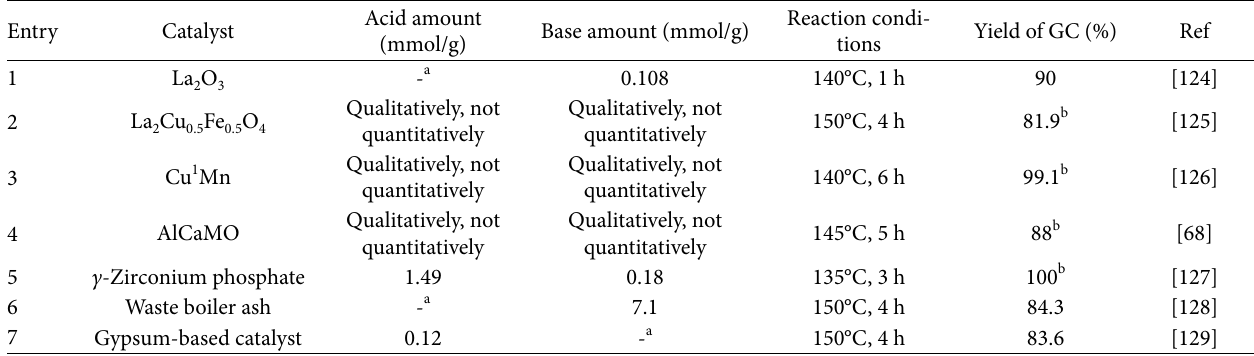
Table 5: Catalytic glycerolysis of urea to GC with other